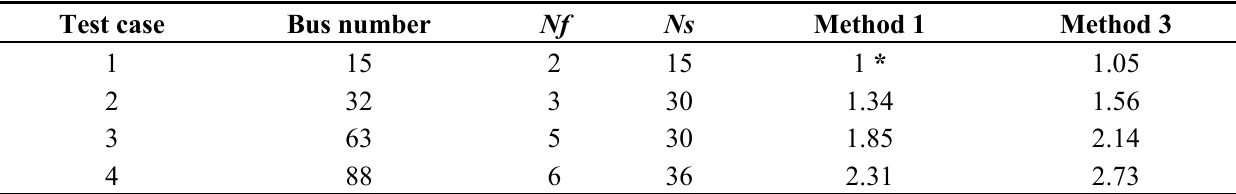
Table 9. Performance comparisons for Methods 1 and 3 excluding the computational time of load